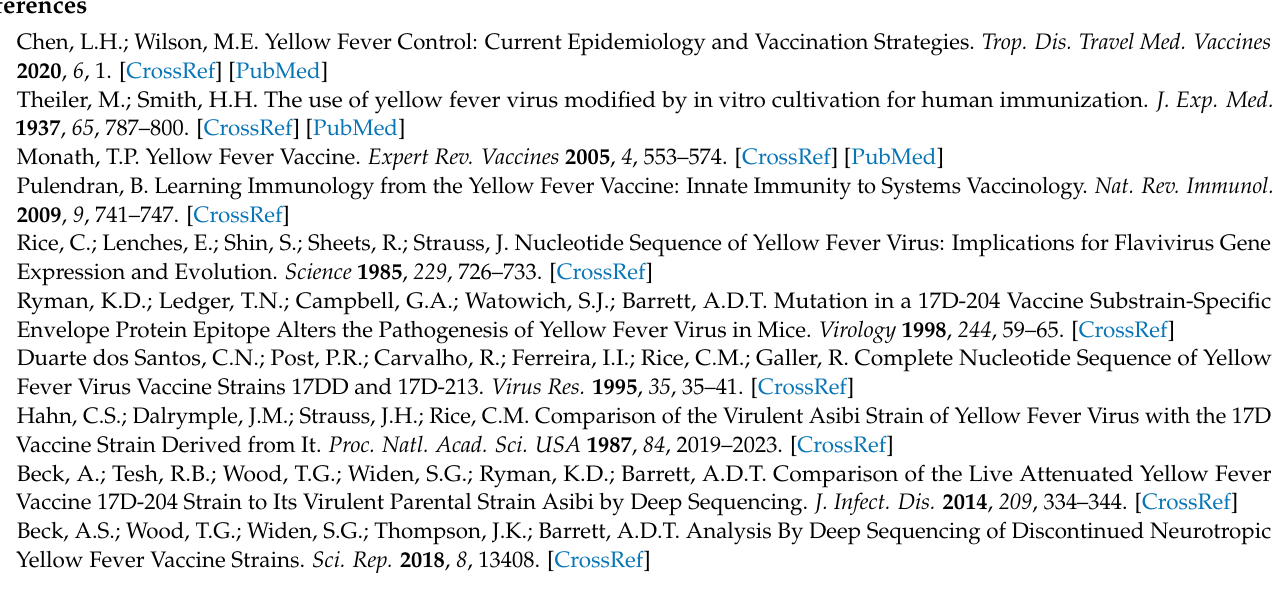
5/13/1/96/s1, Figure S1: Gating strategy for activated T lymphocytes and monocytes by flow cytom- etry, Figure S2: CLEC5A and IFN- γ protein levels according SNPs analyzed, Table S1: Descriptions of genes, main immunological roles and primer pairs, Table S2: Selected SNPs